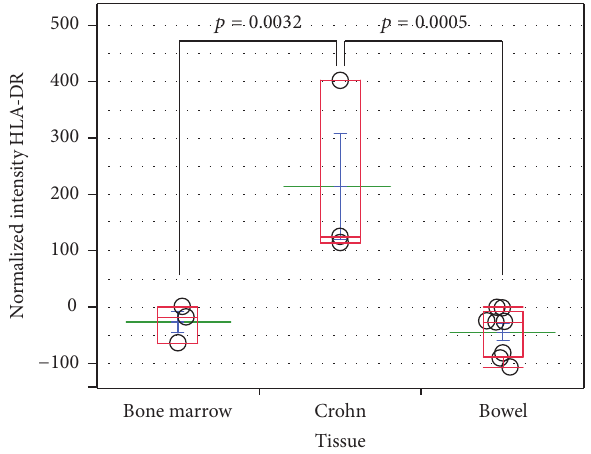
Figure 1: HLA-DR levels in Crohn’s-derived versus bowel- and bone marrow-derived MSCs. Dot plot of normalized fluorescence intensities from flow cytometric analysis of HLA-DR expression in Crohn, colon, and bone marrow MSCs. MSCs obtained from colon and bone marrow samples are consistently negative for HLA-DR, a major histocompatibility complex (MHC) Class II antigen, whereas Crohn’s-derived MSCs constitutively express statistically significant levels. The antibody used was R-phycoerythrin-labeled mouse anti- human HLA-DR (Becton-Dickinson). Mean fluorescence intensity (MFI) of isotype control was subtracted to MFI from HLA-DR intensity to generate the plotted normalized intensities. 𝑝 values were obtained by performing Student’s 𝑡 -test via SAS JMP v10 software (SAS Institute Inc., Cary,